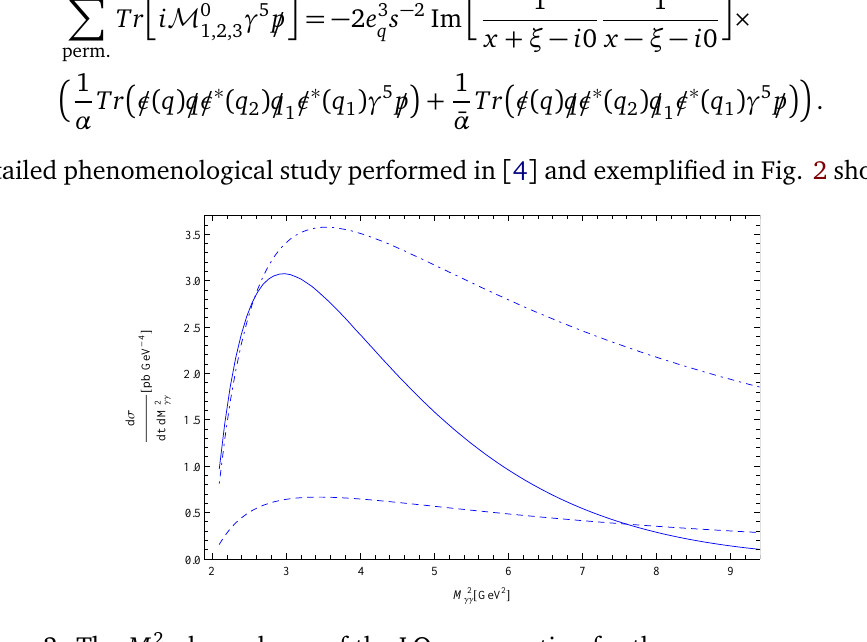
Figure 2: The M 2 dependence of the LO cross-section for the process γ p → γγ p (cid:48) at γγ s = 20 (resp. 100, resp 10 6 ) GeV 2 : full (resp. dashed, resp. dash-dotted) curve. The highest energy curve is multiplied by 10 5